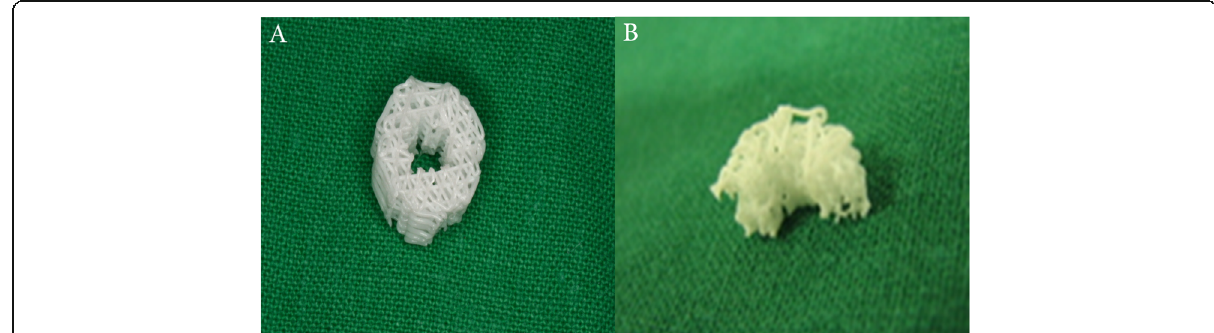
Fig. 1 The PCL-TCP scaffold structure. a Tube-shape scaffold with 4-mm inner diameter, 8-mm outer diameter, 4-mm height, and 2-mm thickness. b The scaffold was cut in half to fit the created buccal mandibular bony defects